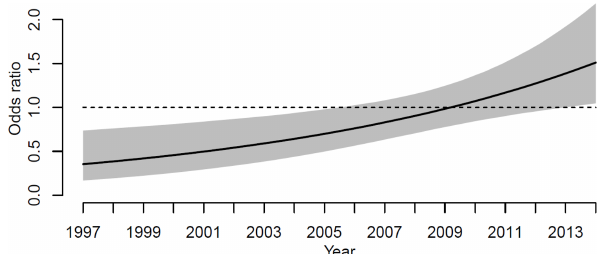
Figure 3. The odds ratio for revision due to infection when compar- ing the seasons for primary procedure (May to August vs. Septem- ber to April). The line shows the odds ratio and the gray region its corresponding point-wise 95% confidence